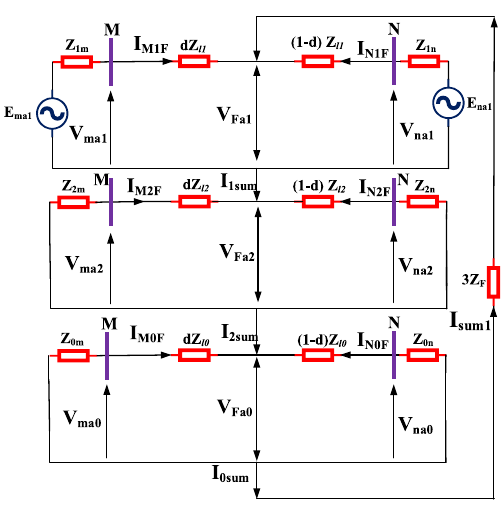
Fig. 2 Sequence network for single line-to-ground